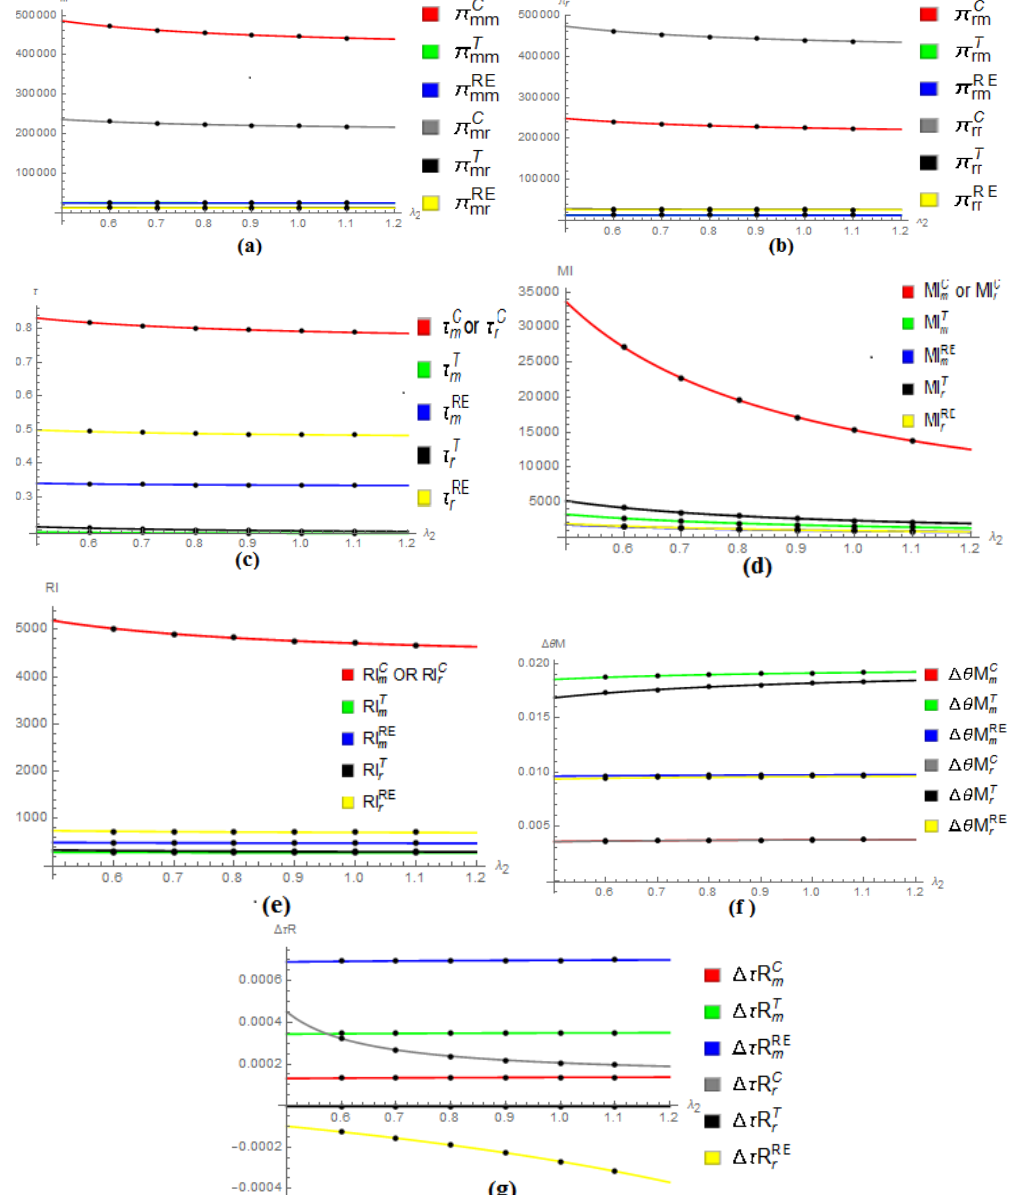
Figure 2. Graphical representation of ( a ) profit of manufacturer, ( b ) profit of retailer, ( c ) used product return, ( d ) manufacturer’s R&D investment to produce product, ( e ) investment effort in encouraging used product collection, ( f ) ratios of relative change of greening levels with investment to produce greener product, and ( g ) ratios of relative change of return rate with investment effort to stimulate product return for the manufacturer in Scenarios MC, RC, MRE, RRE, MT, and